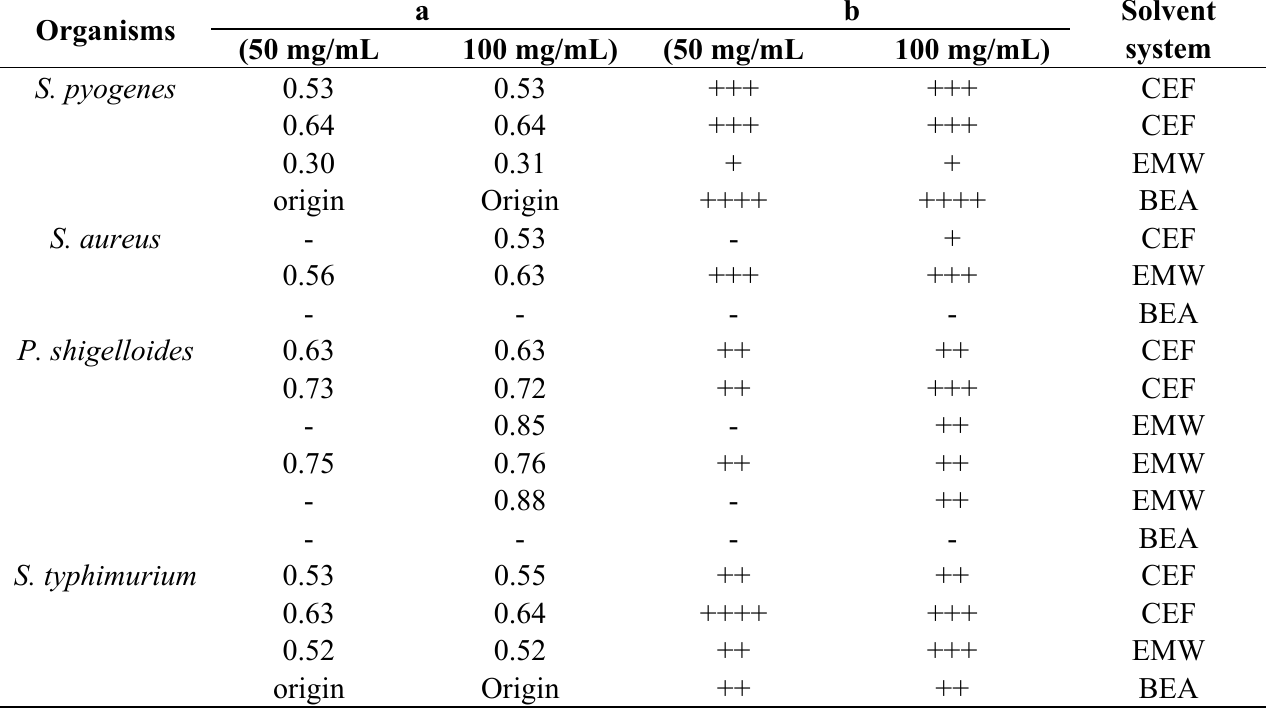
Table 4. Inhibition of bacterial species by methanol extract using